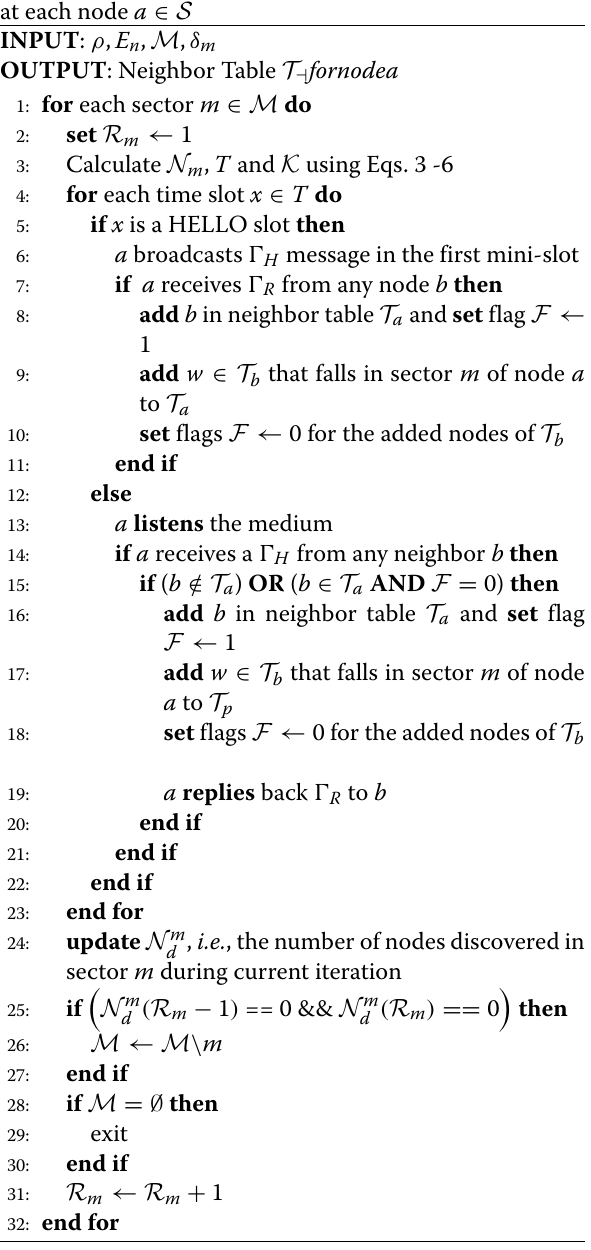
Algorithm 1 Collaborative neighbor discovery